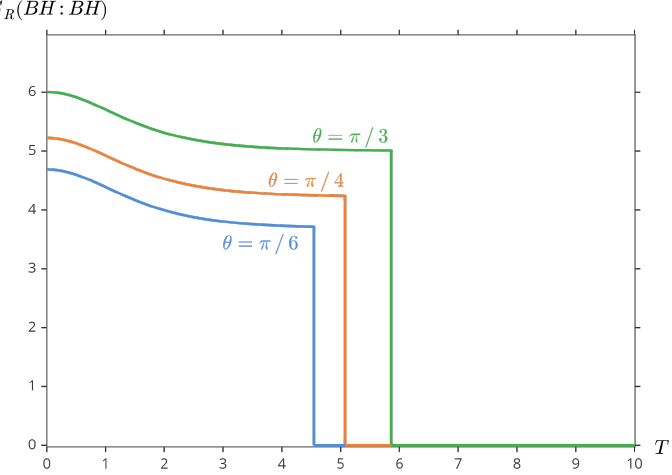
Figure 13. The reflected entropy between black hole interiors (in the unit of c time T for X 0 = 1 and θ = π